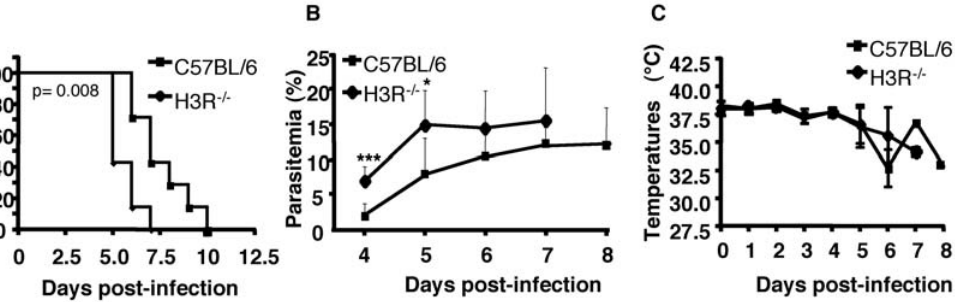
Figure 1. Role of H3R in Plasmodiumberghei infection. H3R 2 / 2 and C57BL/6 mice were inoculated with 10 6 infected erthrocytes with Pb ANKA. Kaplan-Meier Survival plots (A), parasitemia (B), and body temperature (C) were recorded. Significant differences in mortality/survival were observed between C57BL/6 and H3R 2 / 2 mice using the log-rank test (n=6, p=0.0092). Differences in parasitemia between groups are significant at day 4 and 5 (Mann-whitney test, *** p=0.0015, and *p=0.0125, respectively), values represent mean 6 s.d. Data shown are representative of four independent experiments.